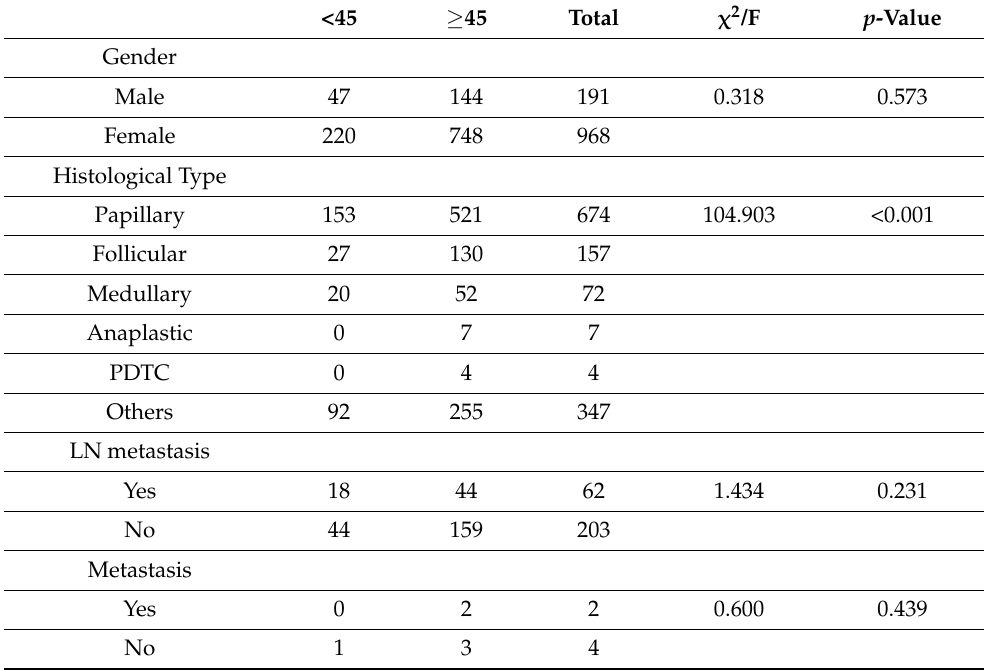
Table 4. Characteristics of thyroid cancer patients aged ≤ 45 and > 45 years as in TNM staging by 7th AJCC